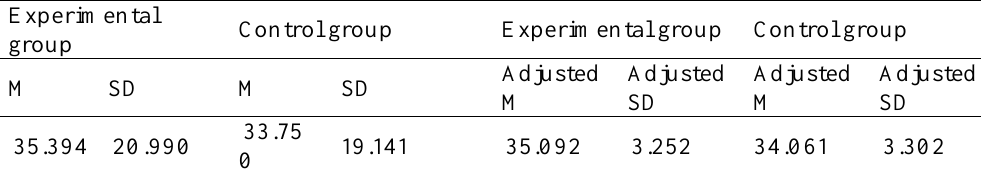
ANCOVA Summary on Achievement Test Scores of Both Groups Source Covariance (average score